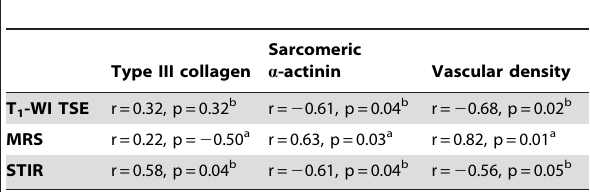
Table 2. Relation between the T 1 W and between MRS and histological outcomes